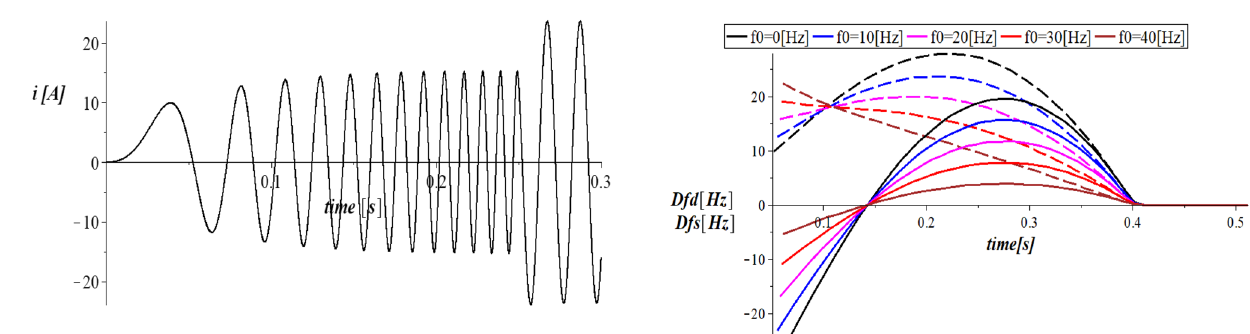
Fig. 4 Frequency increase of voltage integral (8), for f 0 = 0,10,20, 30,40 (Hz) , f k = 50 (Hz) , T = 0.6 (s)